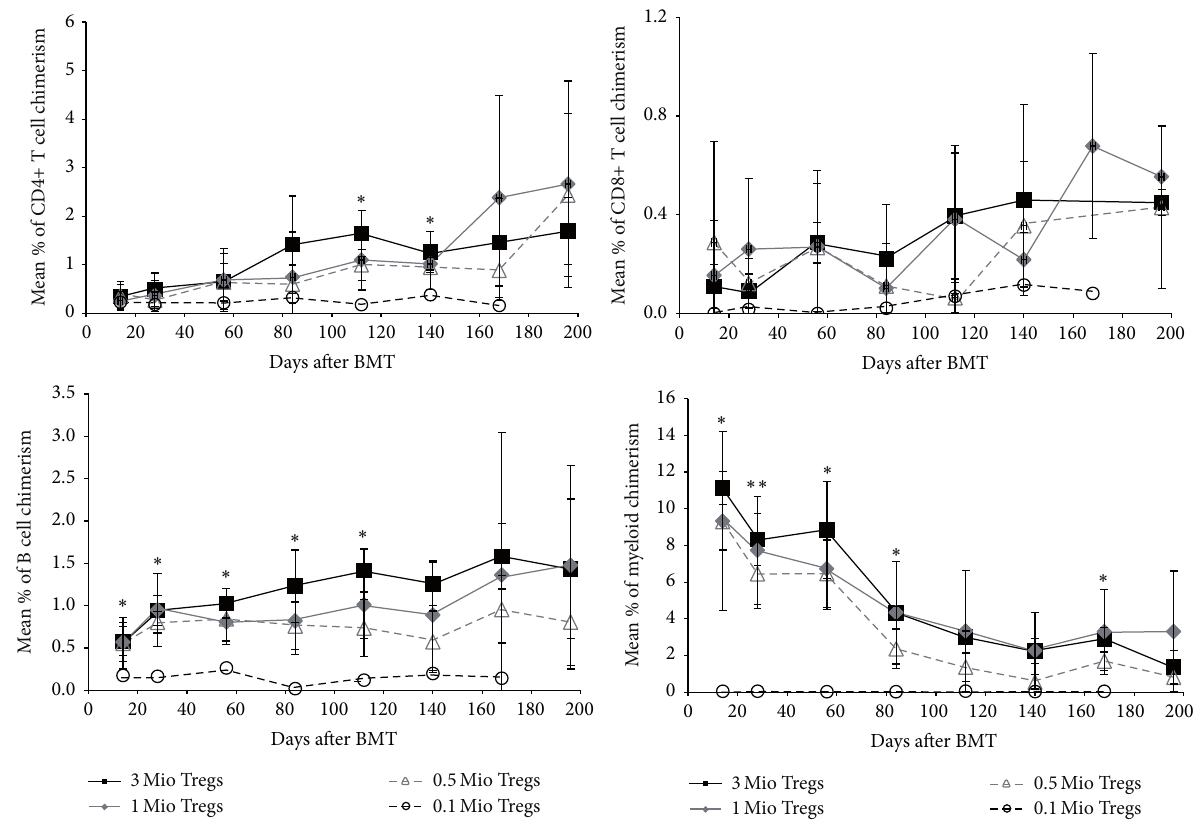
Figure 2: Therapeutic nTreg treatment induces multilineage chimerism at doses of 3, 1, and 0.5 × 10 6 cells without cytoreduction. B6 BMT recipients were treated with different doses of recipient nTregs ( ◼ 3 × 10 6 cells, 𝑛 = 4 ; X 1 × 10 6 cells, 𝑛 = 8 ; 󳵻 0.5 × 10 6 cells, 𝑛 = 6 ; I 0.1 × 10 6 cells, 𝑛 = 6 ). Donor (H-2D d + ) chimerism among leukocytes of T cell (CD4 + and CD8 + ), B cell (B220 + ), and the myeloid (Mac1 + ) lineage was assessed by flow cytometry of peripheral blood at multiple time points and is shown as mean percent (error bars indicate standard deviation). Data are representative for at least 3 independent experiments per